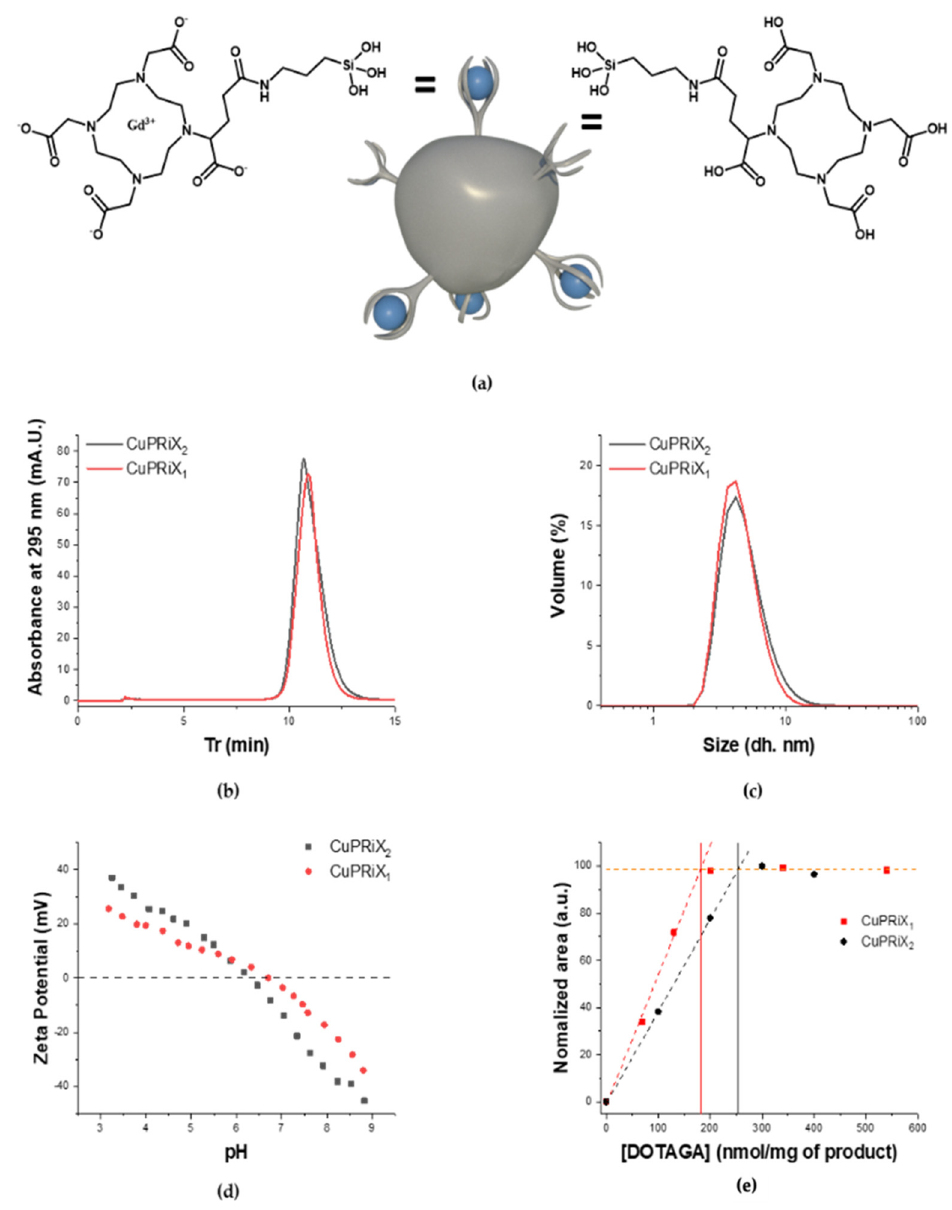
Figure 2. ( a ) Schematic representation of CuPRiX X with a detailed structure of DOTAGA(Gd) and uncomplexed DOTAGA groups; ( b ) HPLC-UV chromatograms of CuPRiX 1 and CuPRiX 2 (10 µL, 100 g/L) recorded at 295 nm; ( c ) Hydrodynamic diameter distribution in volume obtained by dynamic light scattering; ( d ) Zeta potential vs. pH for CuPRiX 1 and CuPRiX 2 ; ( e ) Comparison of the amount of DOTA groups between CuPRiX 1 and CuPRiX 2 based on their unchelated DOTAGA measurements.